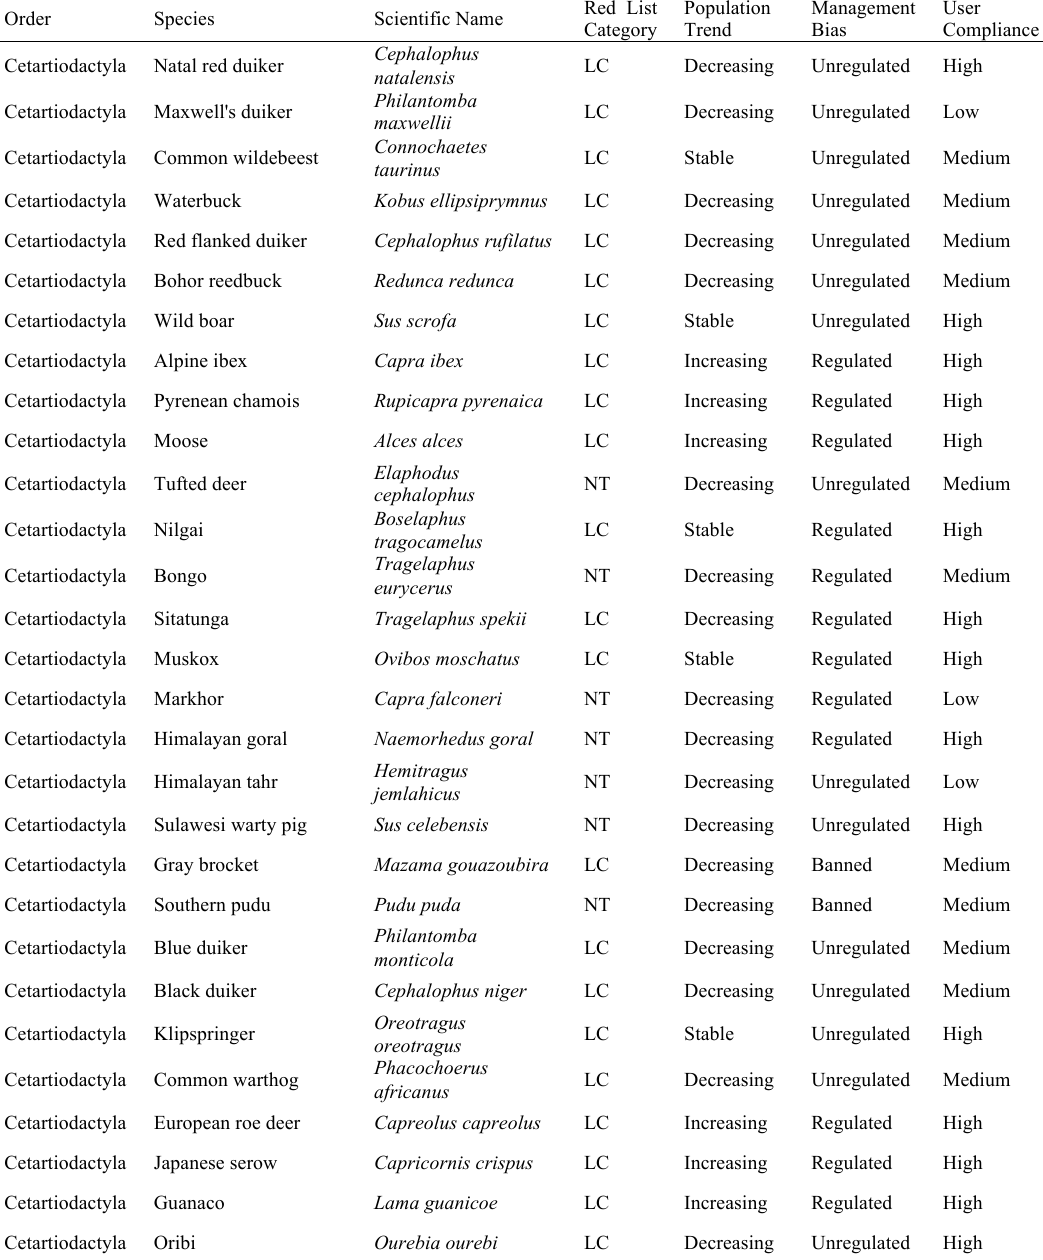
Table A6.1 . List of IUCN Red List species and associated population trend, decision- making bias and user compliance